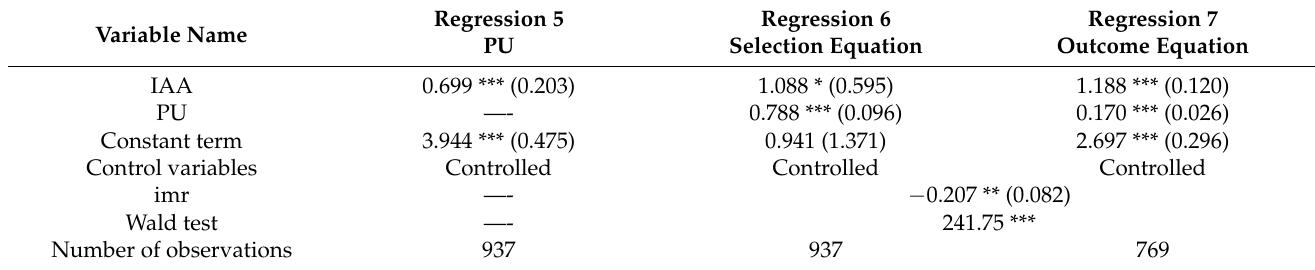
Table 7. Results of the mediating effects test for perceived